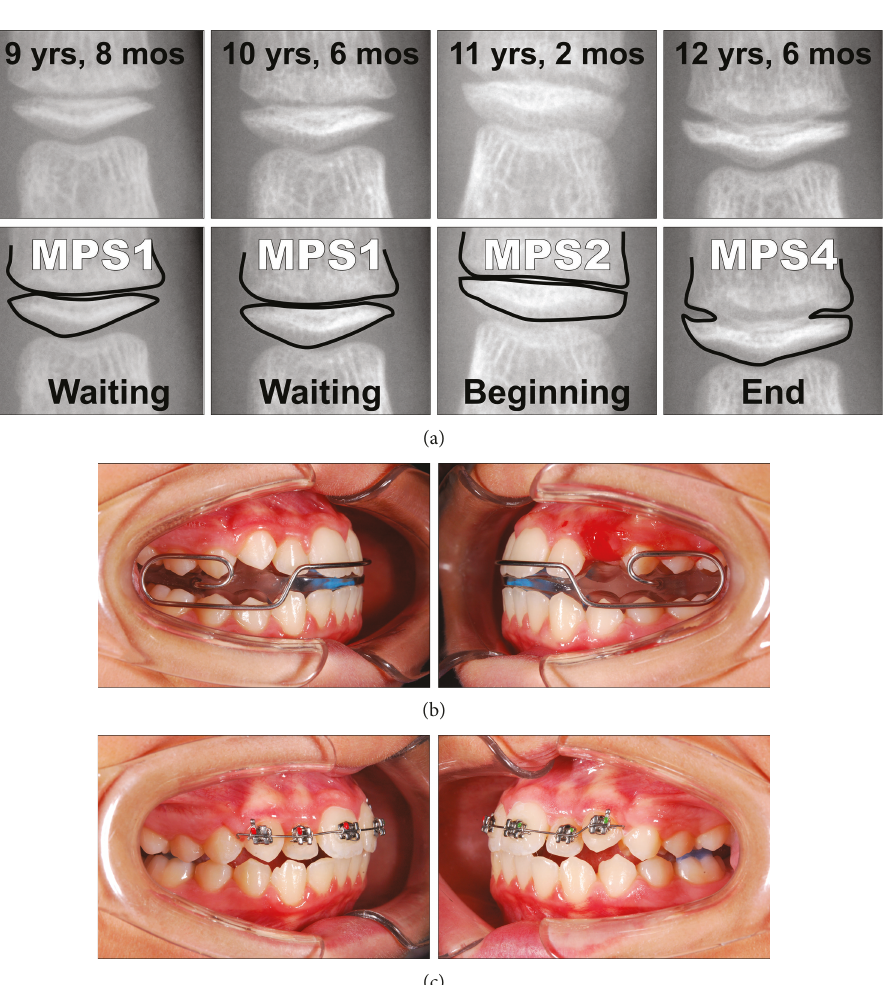
Figure 7: Case 2. (a) The series of the MPM recordings with corresponding ages and according to the timing of functional treatment (waiting before treatment, beginning of treatment, and end of treatment). (b) Intraoral views of the Bionator appliance. (c) The fi xed appliance on the maxillary anterior